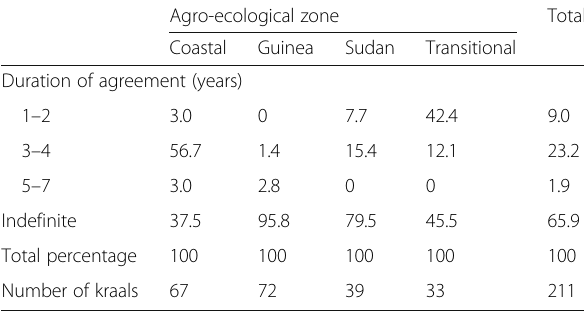
Table 6 Distribution (percentage) of the duration of kraal owner – herdsman contracts by agro-ecological zone Agro-ecological